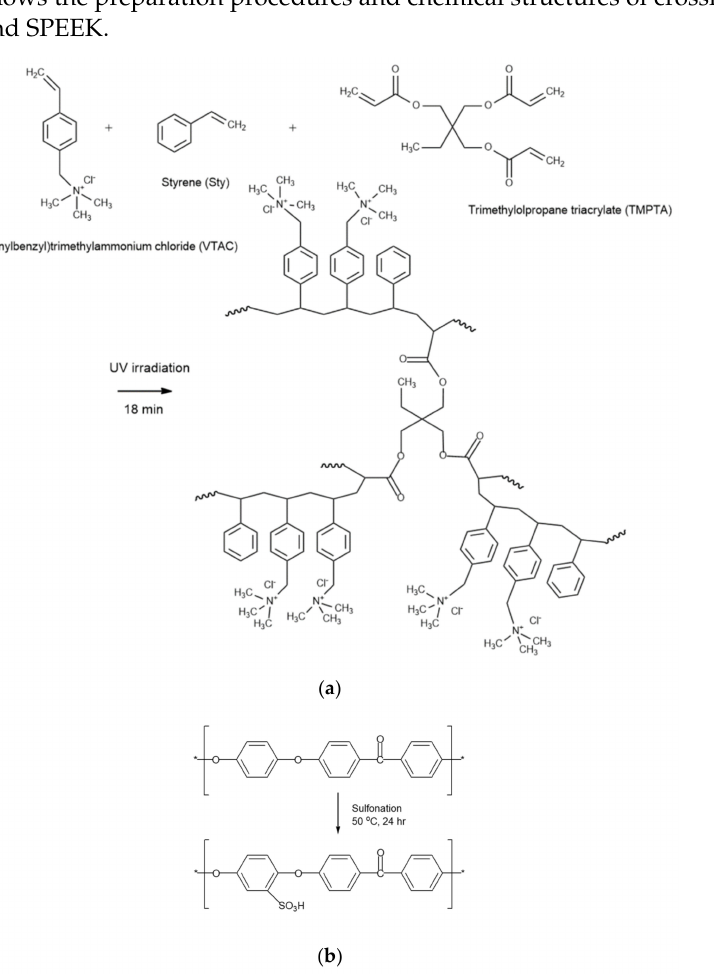
Figure 1. Reaction schemes of ( a ) crosslinked poly(VTAC-Sty) and ( b )